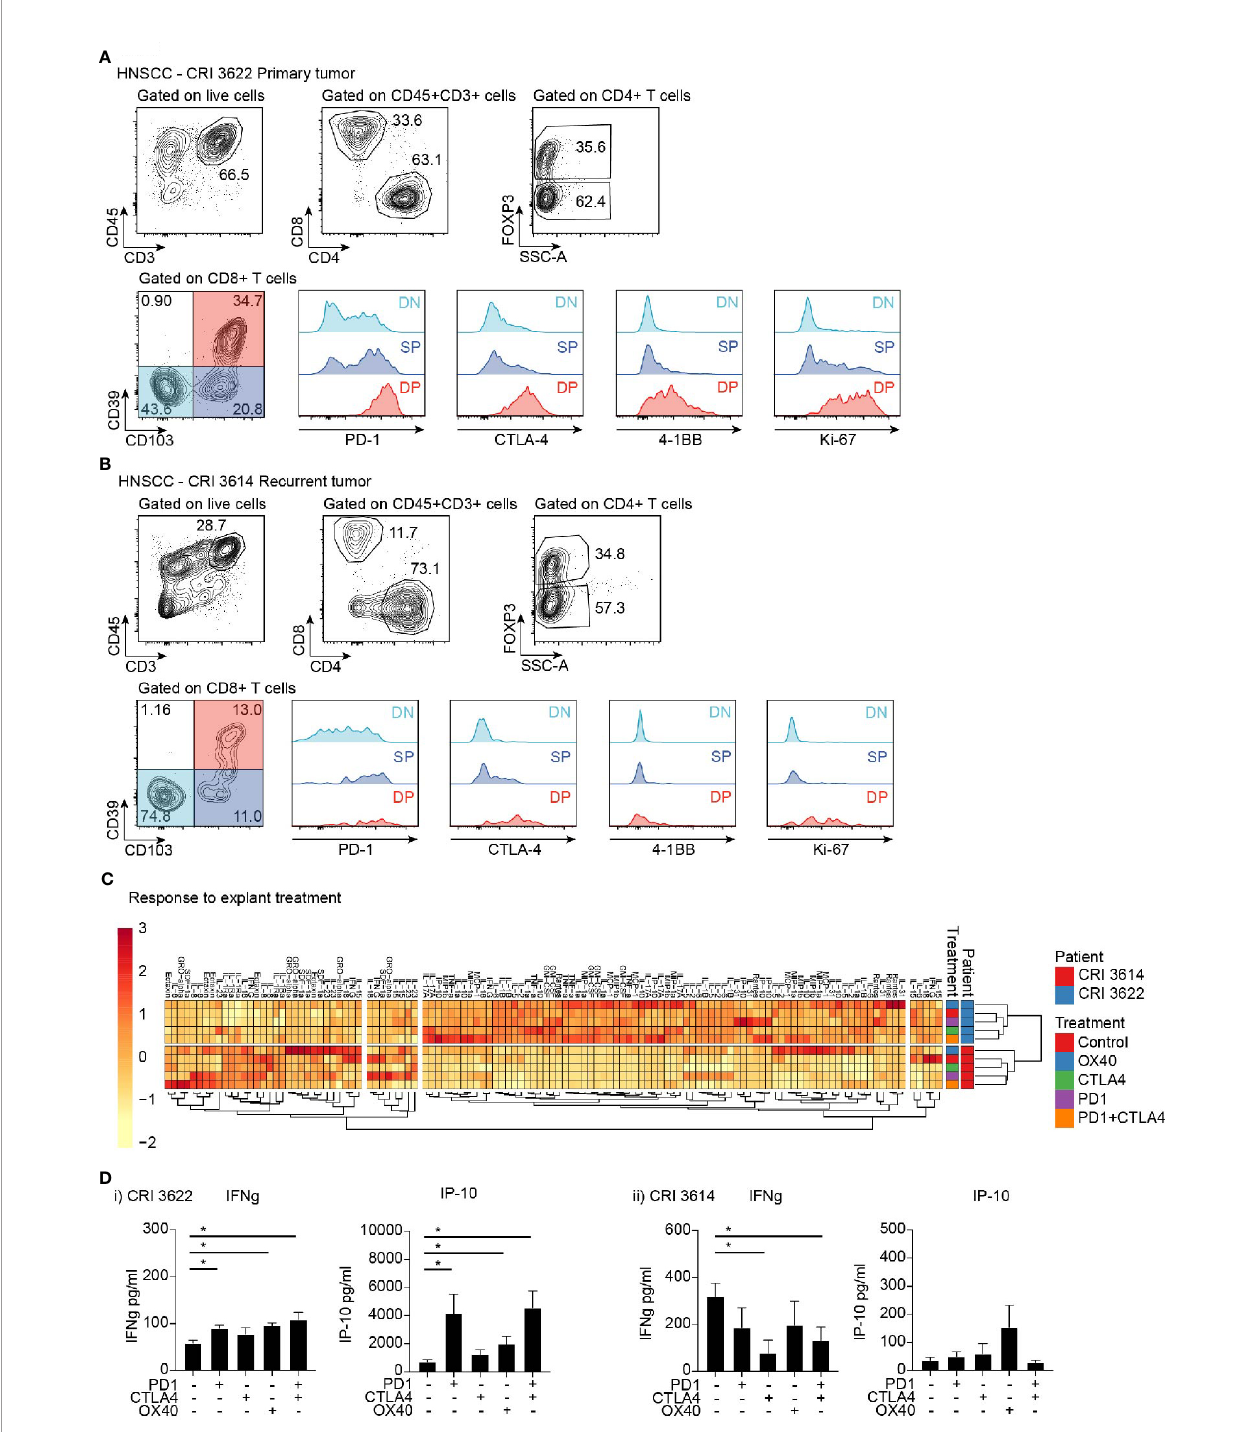
FIGURE 6 | Effect of immunotherapy treatment on cytokine and chemokine secretion from tumor explants. Flow cytometry analysis of in fi ltrating T cell populations in HNSCC patients with (A) primary tumor and (B) recurrent tumor. Gating identi fi es CD4 and CD8 T cell in fi ltrate, as well as FoxP3 + Treg cells, and evaluates critical functional markers on the different CD8 T cell populations identi fi ed by CD39 and CD103 expression. (C) Cytokine and chemokine secretion from tumor explants from patients in (A, B) treated with candidate immunotherapies. Responses are clustered to identify potential coregulated differences. Rows are centered; unit variance scaling is applied to rows. Imputation is used for missing value estimation. Both rows and columns are clustered using correlation distance and average linkage. 120 rows, 8 columns. (D) Explant production of IFNg and IP10 in i) primary tumor and ii) recurrent tumor. Key: NS, not signi fi cant. *p <